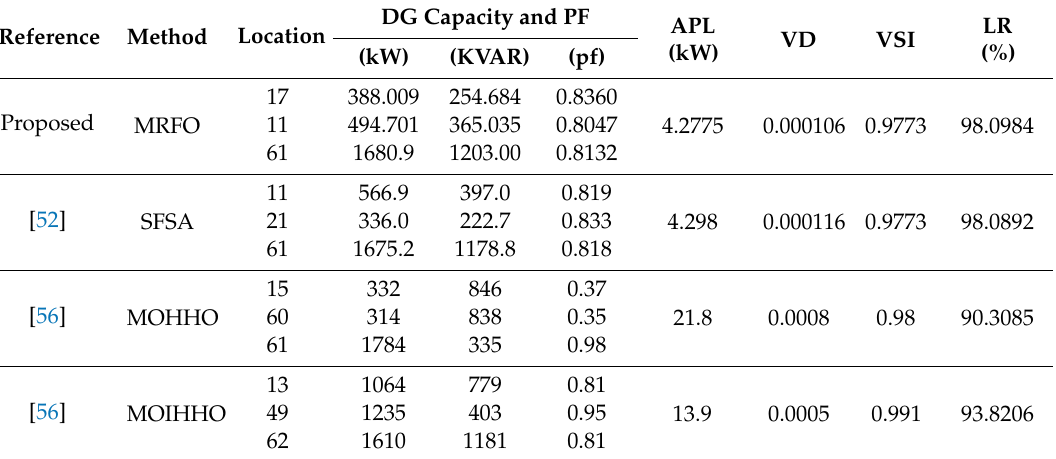
Table 9. 69-bus, three DG units at optimum